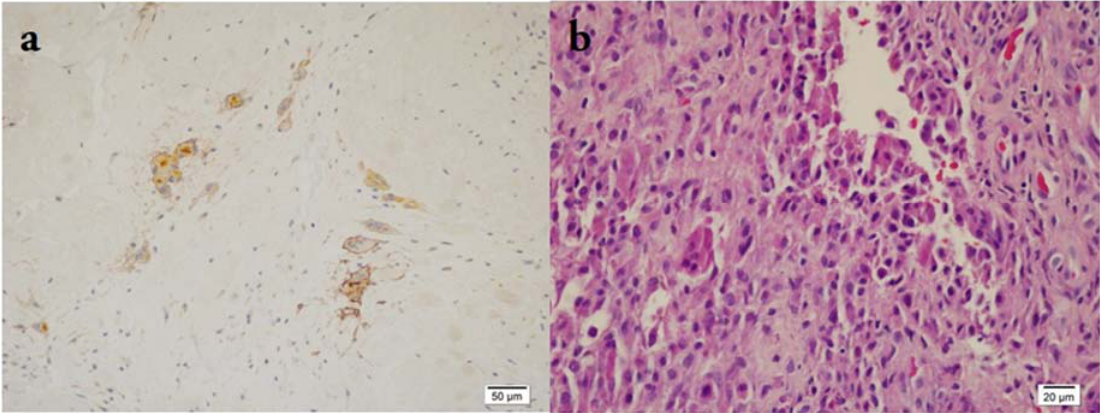
Figure 2. ( a ) Positive expression of PD-L1 in multinuclear cells, 200 × magnification; ( b ) H&E staining of the same sectional area, 400 × magnification. Table 2. Tumor type (localized or diffuse) and PD-L1 staining.